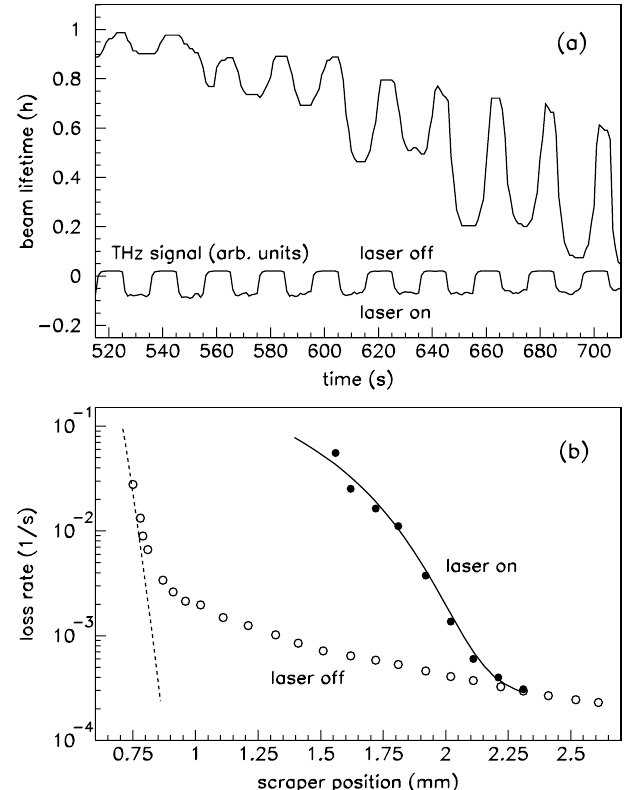
FIG. 5. (a) Beam lifetime and THz radiation intensity as function of time, while a scraper is moved towards the beam and the laser is blocked periodically. (b) Loss rate versus scraper position, where the dashed line indicates the quantum lifetime limit and the solid line is the result of a simulation using measured laser pulse dimensions and varying the laser pulse